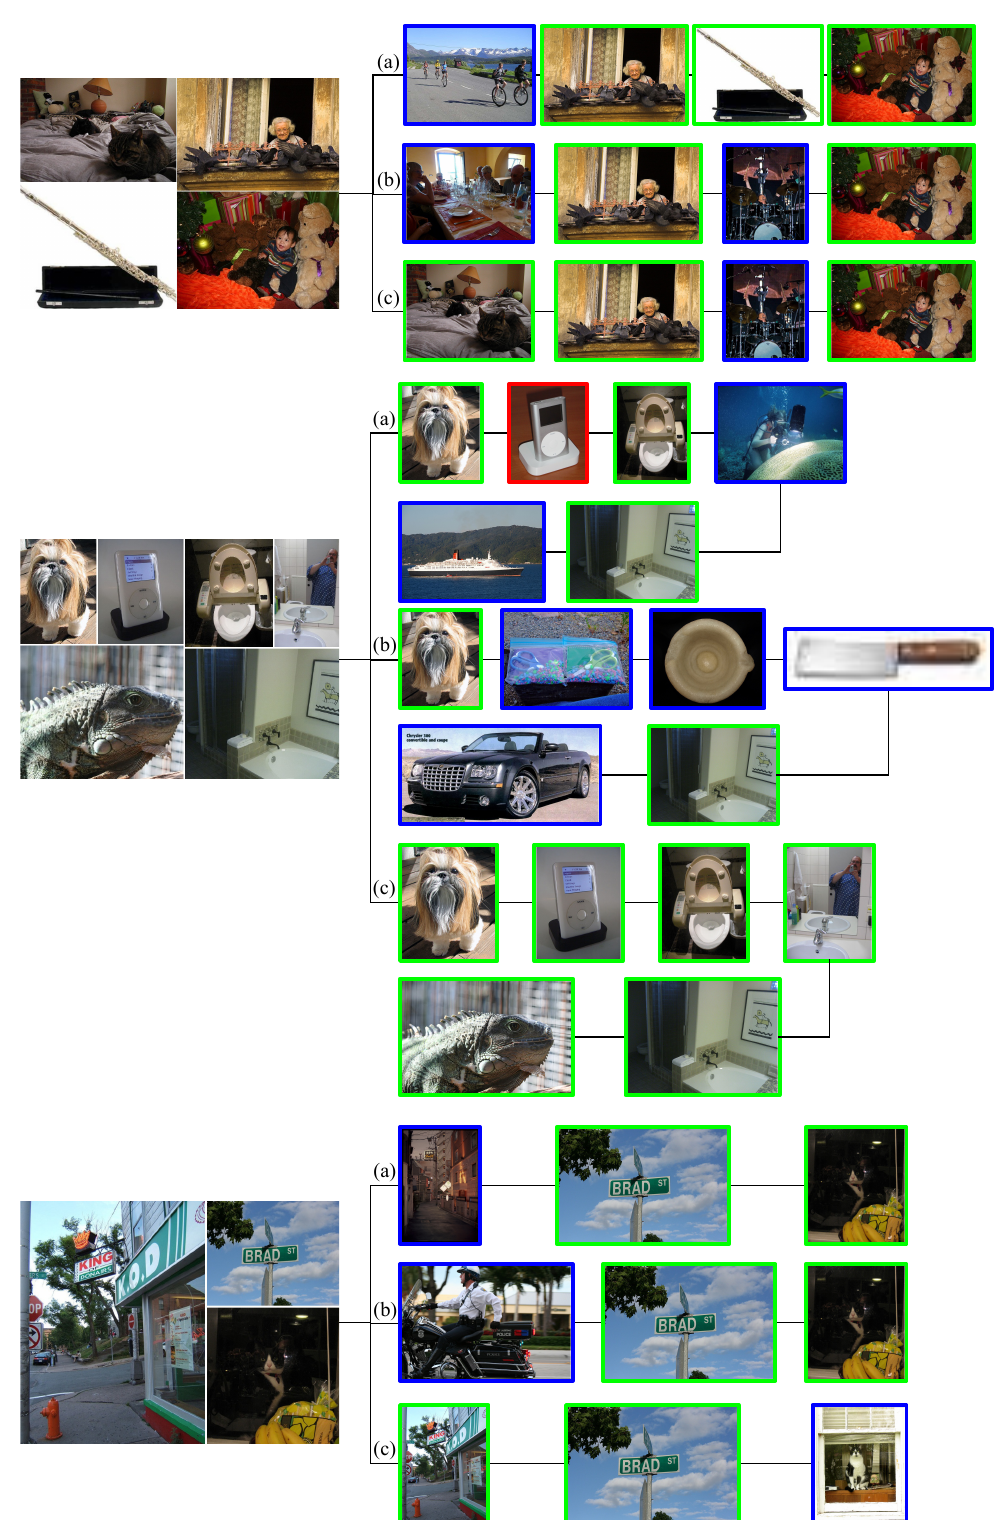
Figure 12. Copyright identification results of image collage queries. ( a – c ) indicate the results of HoG [11], BinaryGAN [10], and the proposed hashing method, respectively. Green, Red, and blue boxes mean identified , misidentified , and unidentified results,